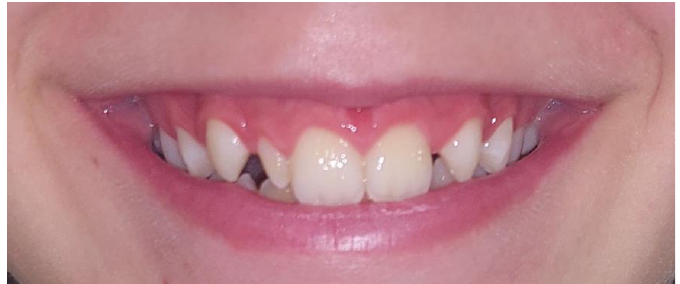
Figure 6. Unattractive smile due to midline asymmetry and space (gaps) caused by right peg-shaped PMLI and hypodontia of left PMLI.